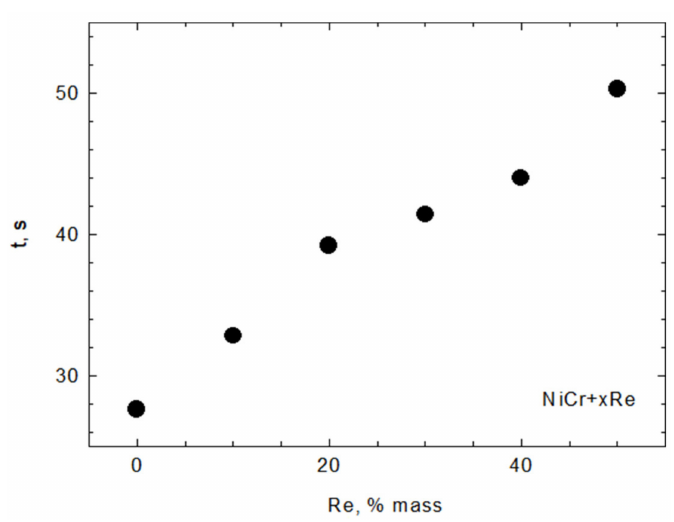
Figure 9. Flowability of NiCr + xRe